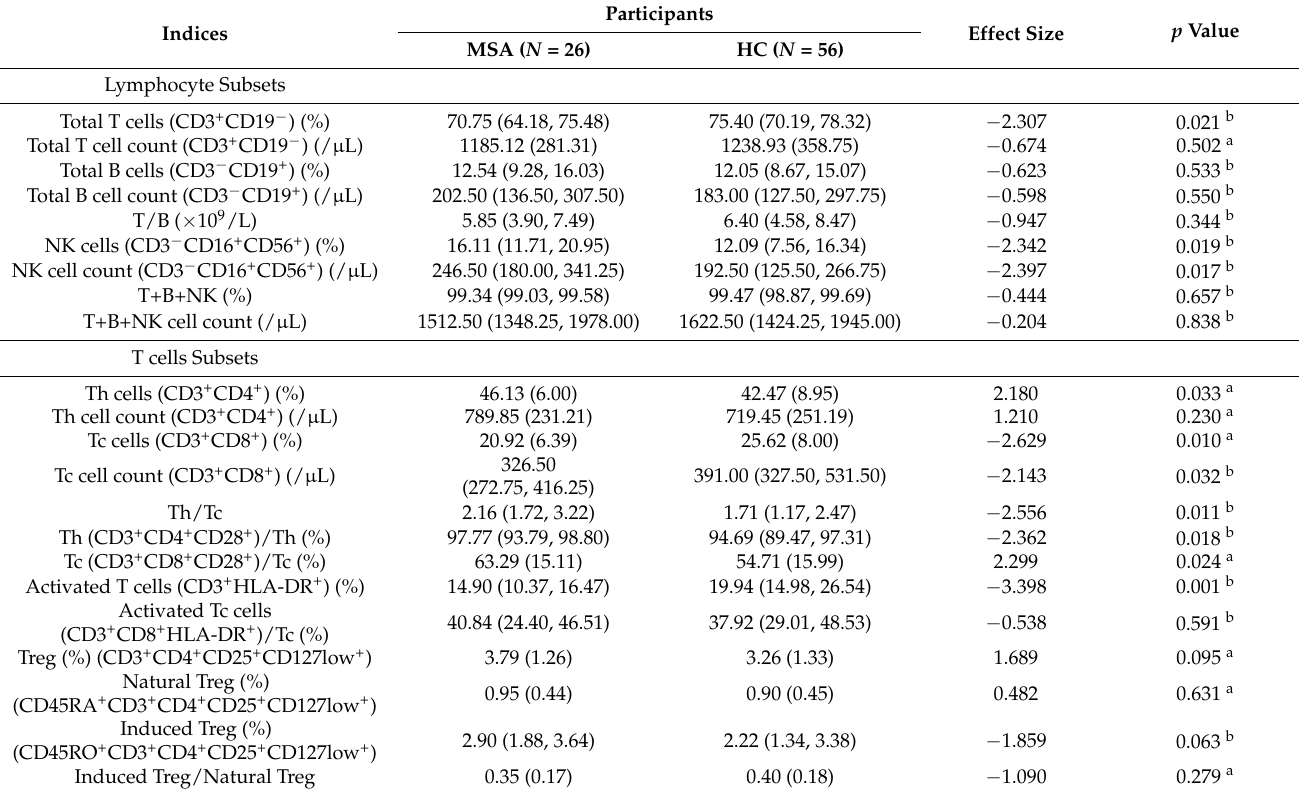
Table 4. Comparison of lymphocyte subsets data between MSA and HC.